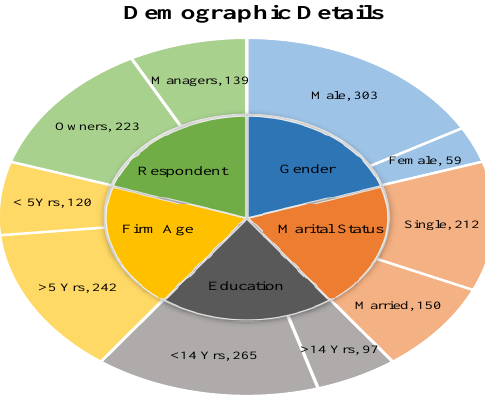
Figure 1: Demographic